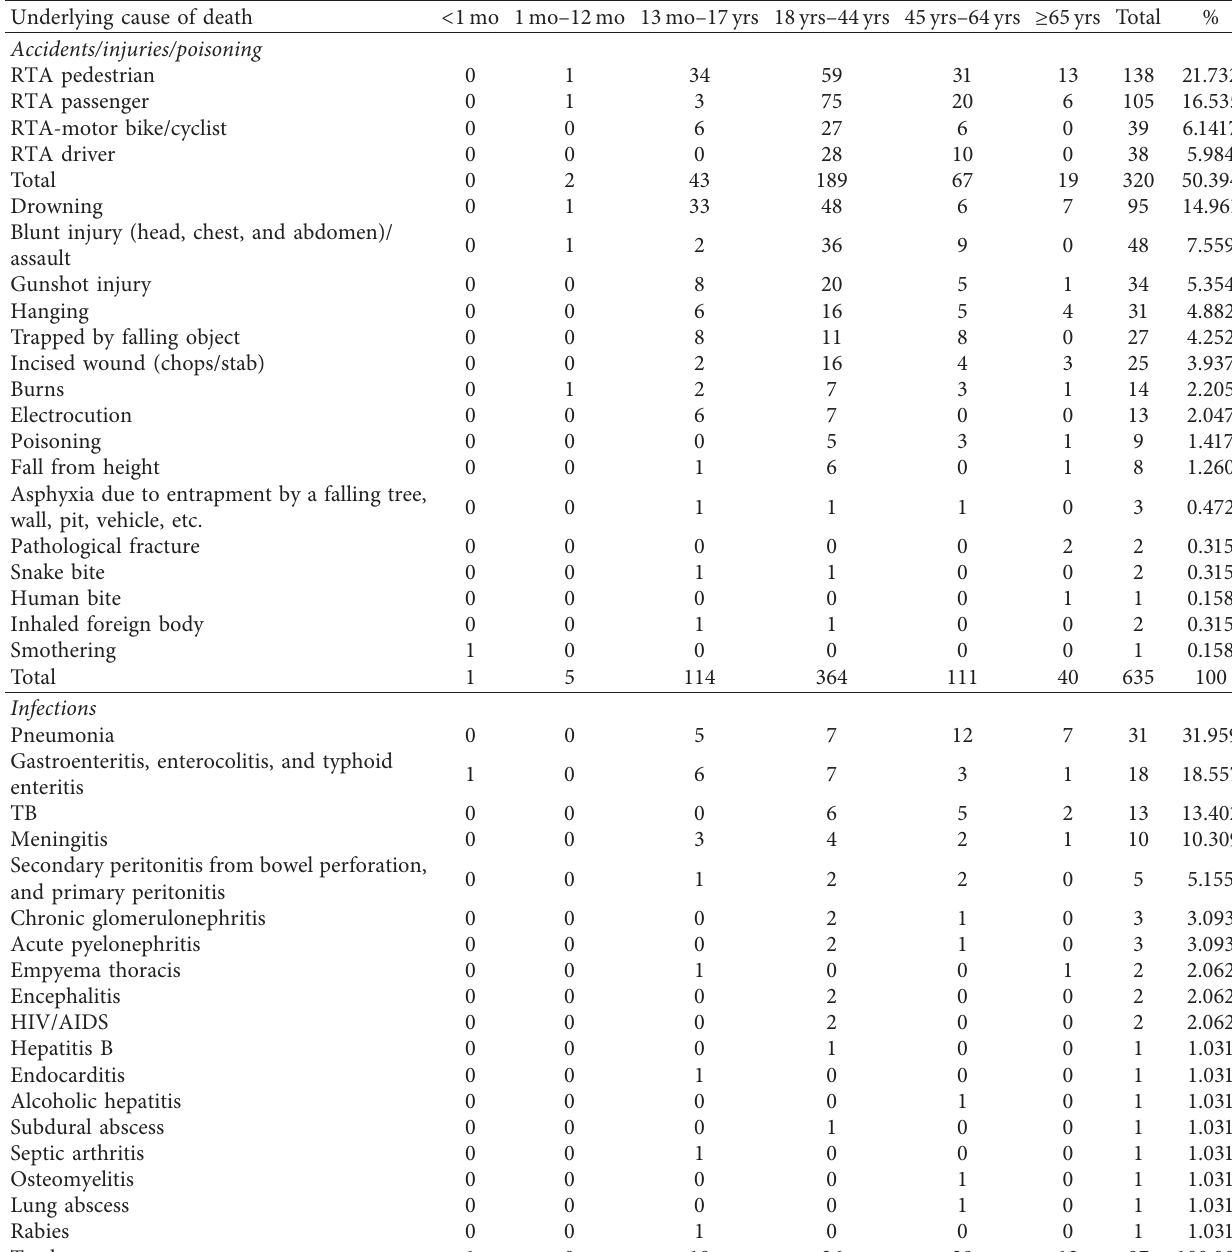
Table 3: Categories of underlying causes of deaths in the